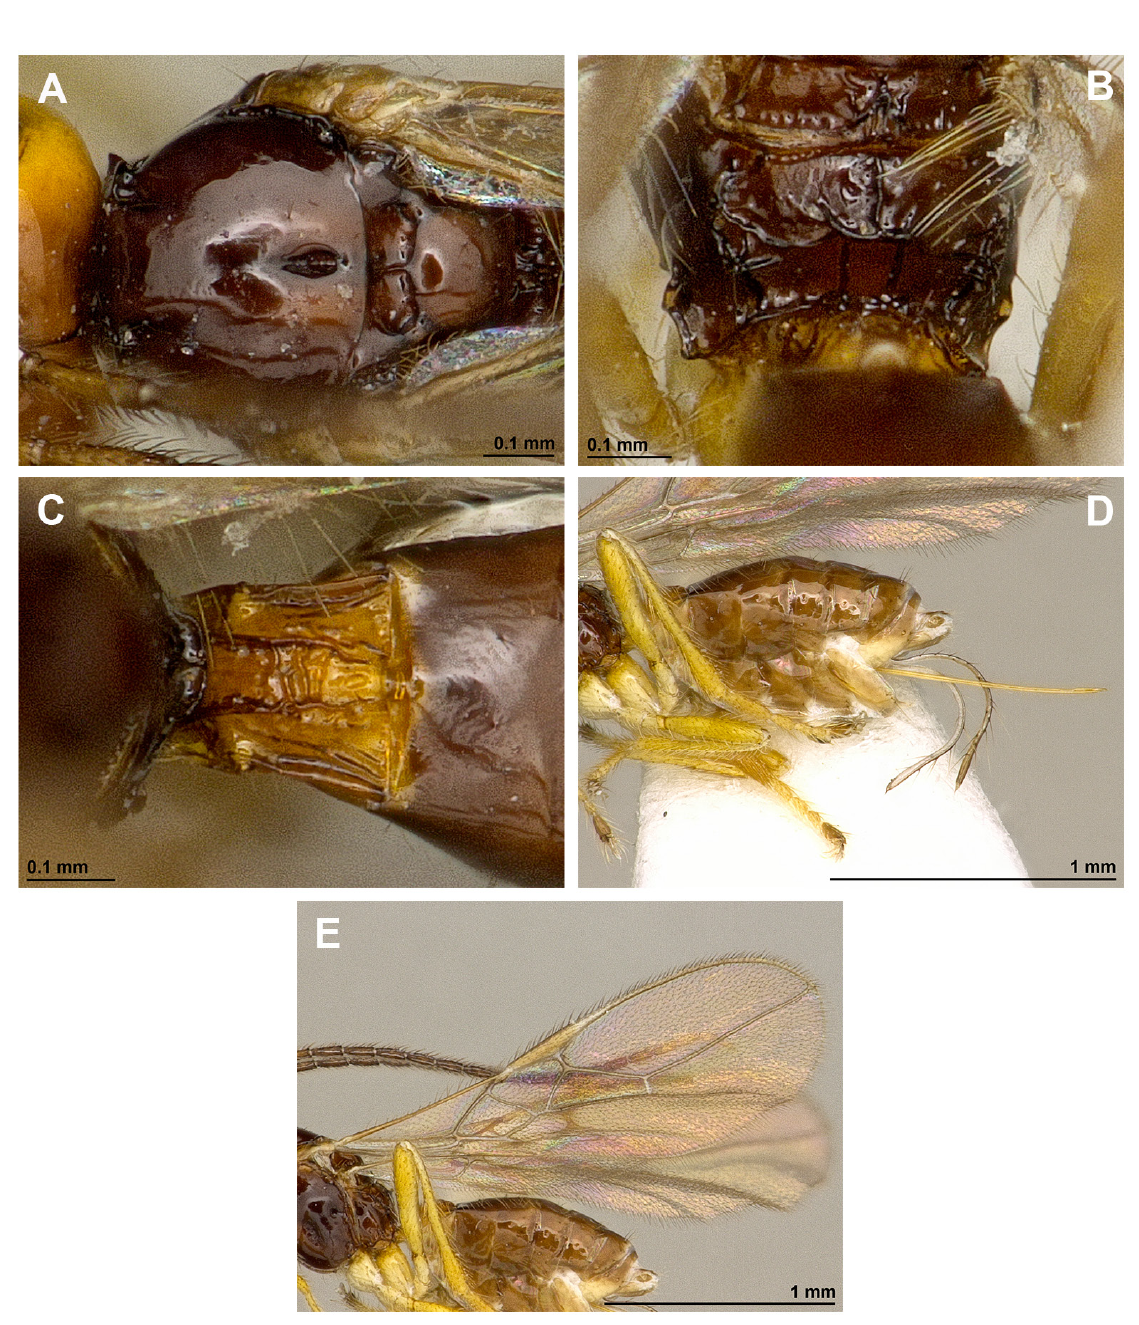
Fig. 42. Asobara mellicephalata van Achterberg, sp. nov., ♀, holotype (RMNH). A . Mesoscutum, dorsal view. B . Propodeum, dorsal view. C . First metasomal tergite, dorsal view. D . Hind leg, metasoma and ovipositor, lateral view. E . Fore